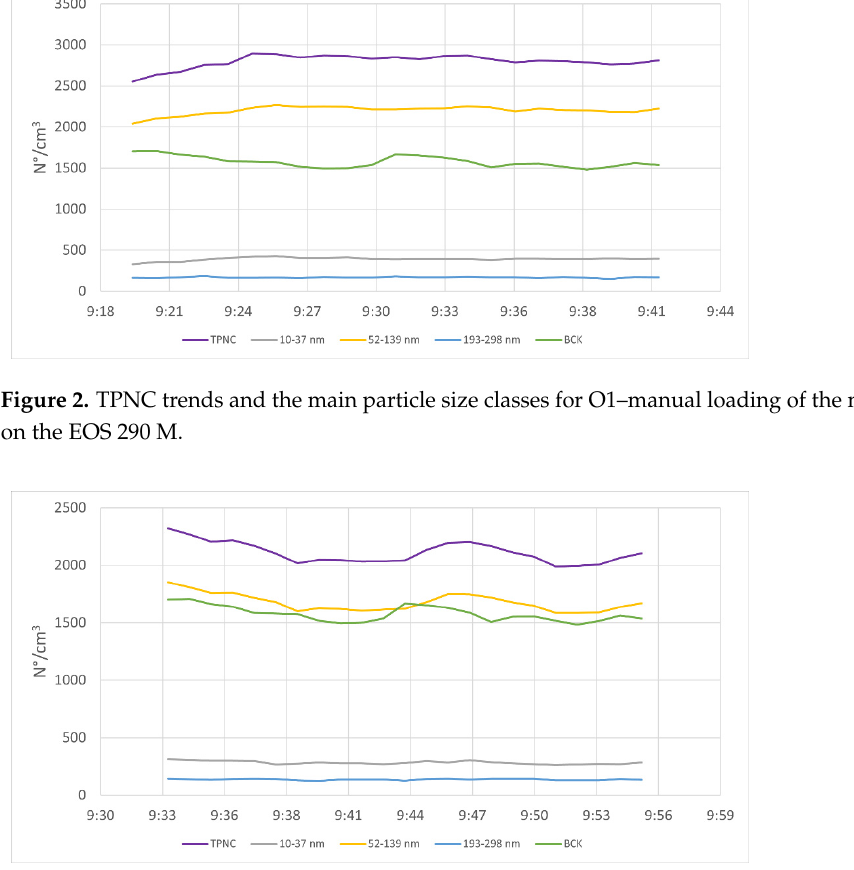
Figure 4. TPNC trends and the main particle size classes for O3–removing and cleaning of the final product and the recovering of unused powder with an external specific vacuum cleaner.